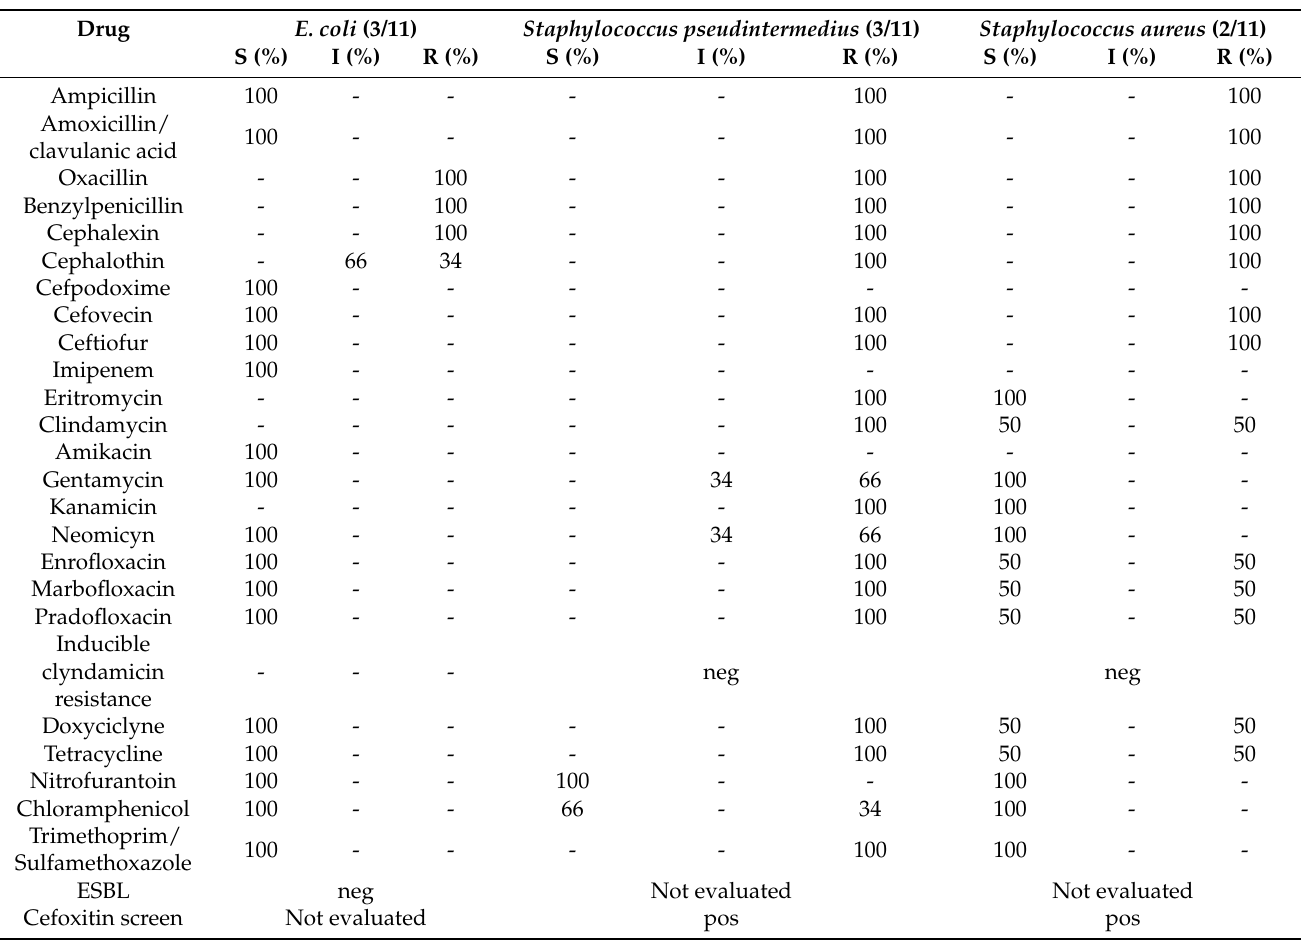
Table 2. Table summarizes most representative bacteria isolated from urine samples in cats ( n = 11). Legend: S = sensitive, I = intermediate, R = resistant. Bacteria were ranked according to minimal inhibitory concentration (MIC) values presented in CLSI guidelines [11].